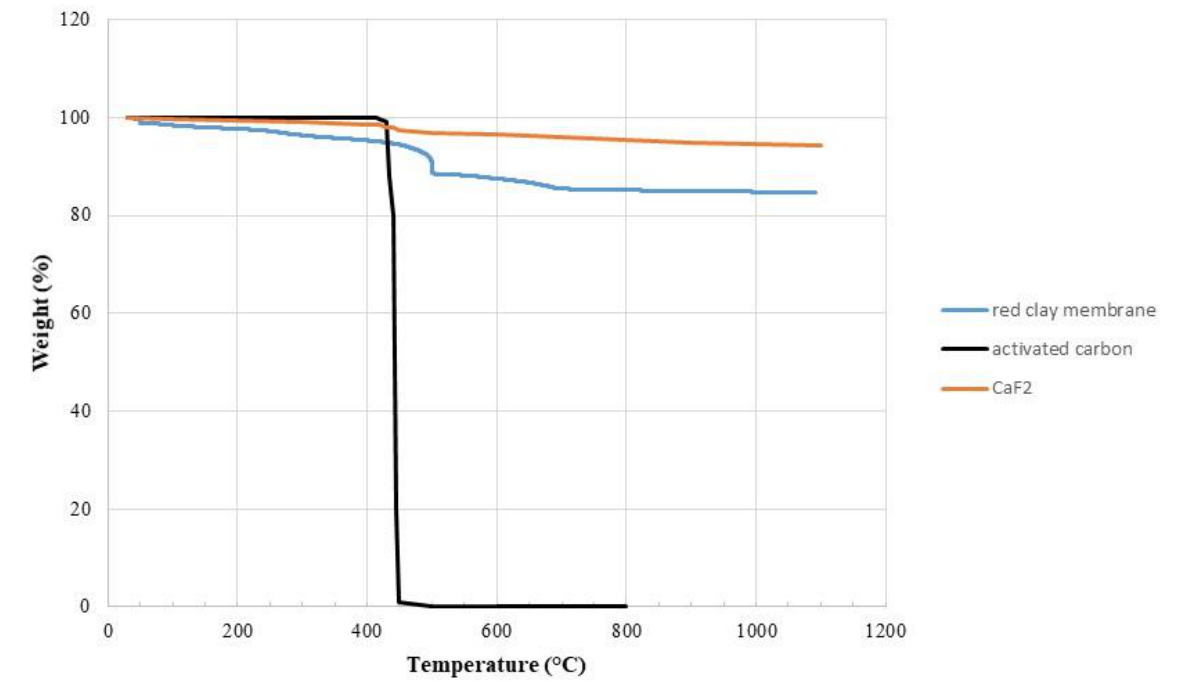
Figure 6. Thermogravimetric analysis of red clay membrane, activated carbon, and CaF 2 under air.